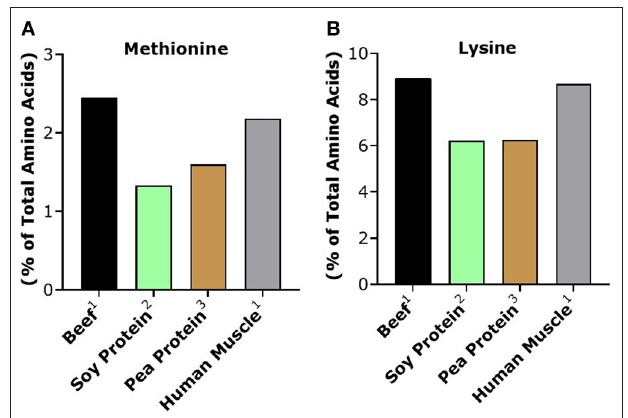
FIGURE 2 | Methionine (A) and lysine (B) content of beef and plant proteins commonly used in plant-based meat alternatives. Human muscle is provided as a reference standard. 1 From Burd et al. (2012). 2 From Tang et al. (2009). 3 From Khattab et al.